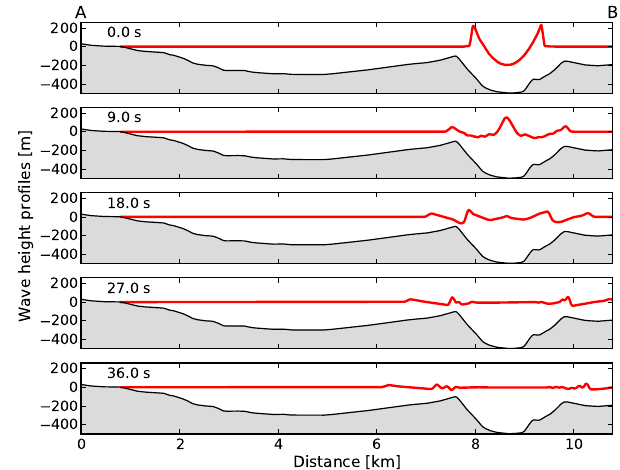
Fig. 6. A bathymetry and topography profiles (shaded areas) along AB line in Fig. 2 north-east of Santorini. Red lines depict the wave height soon after the explosion and show the formation of the posi- tive tsunami leading wave. The explosion centre inside the Kolumbo crater lies at 9km distance. Number in each figure shows time in seconds after the explosion. (Case with η 0 =